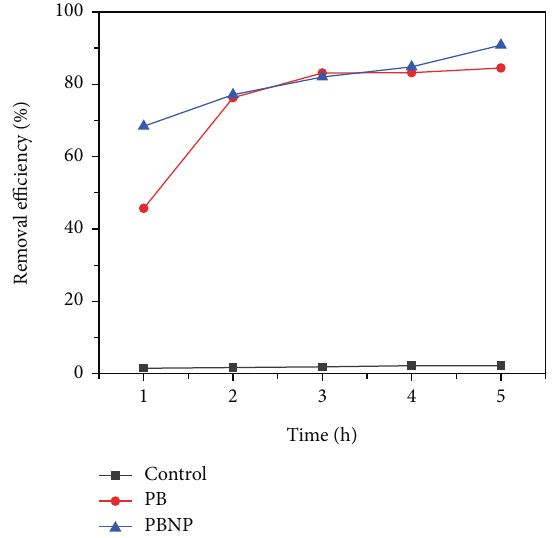
Figure 5: E ff ect of contact time on removal e ffi